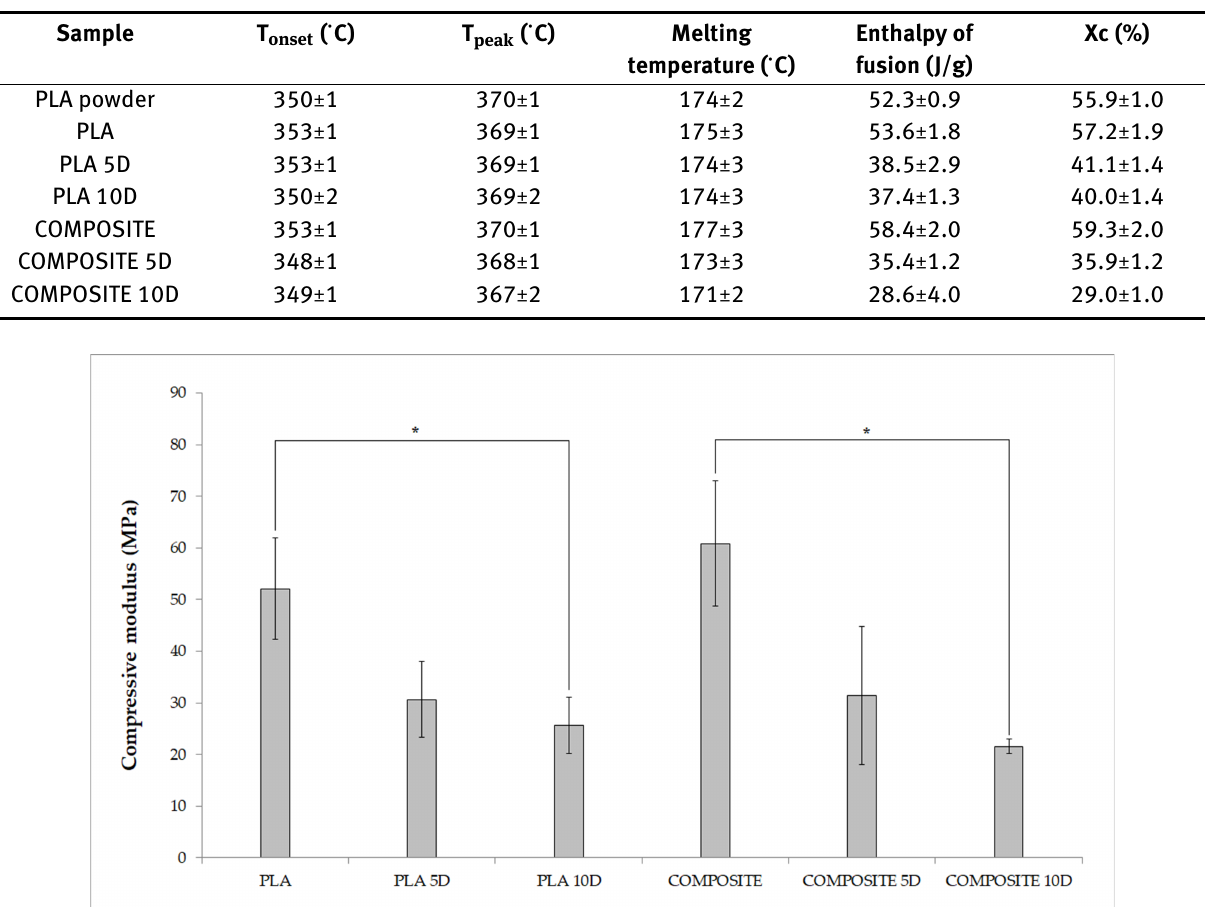
Figure 3: Mechanical properties of the 3D printed scaffolds under compression testing (*p <